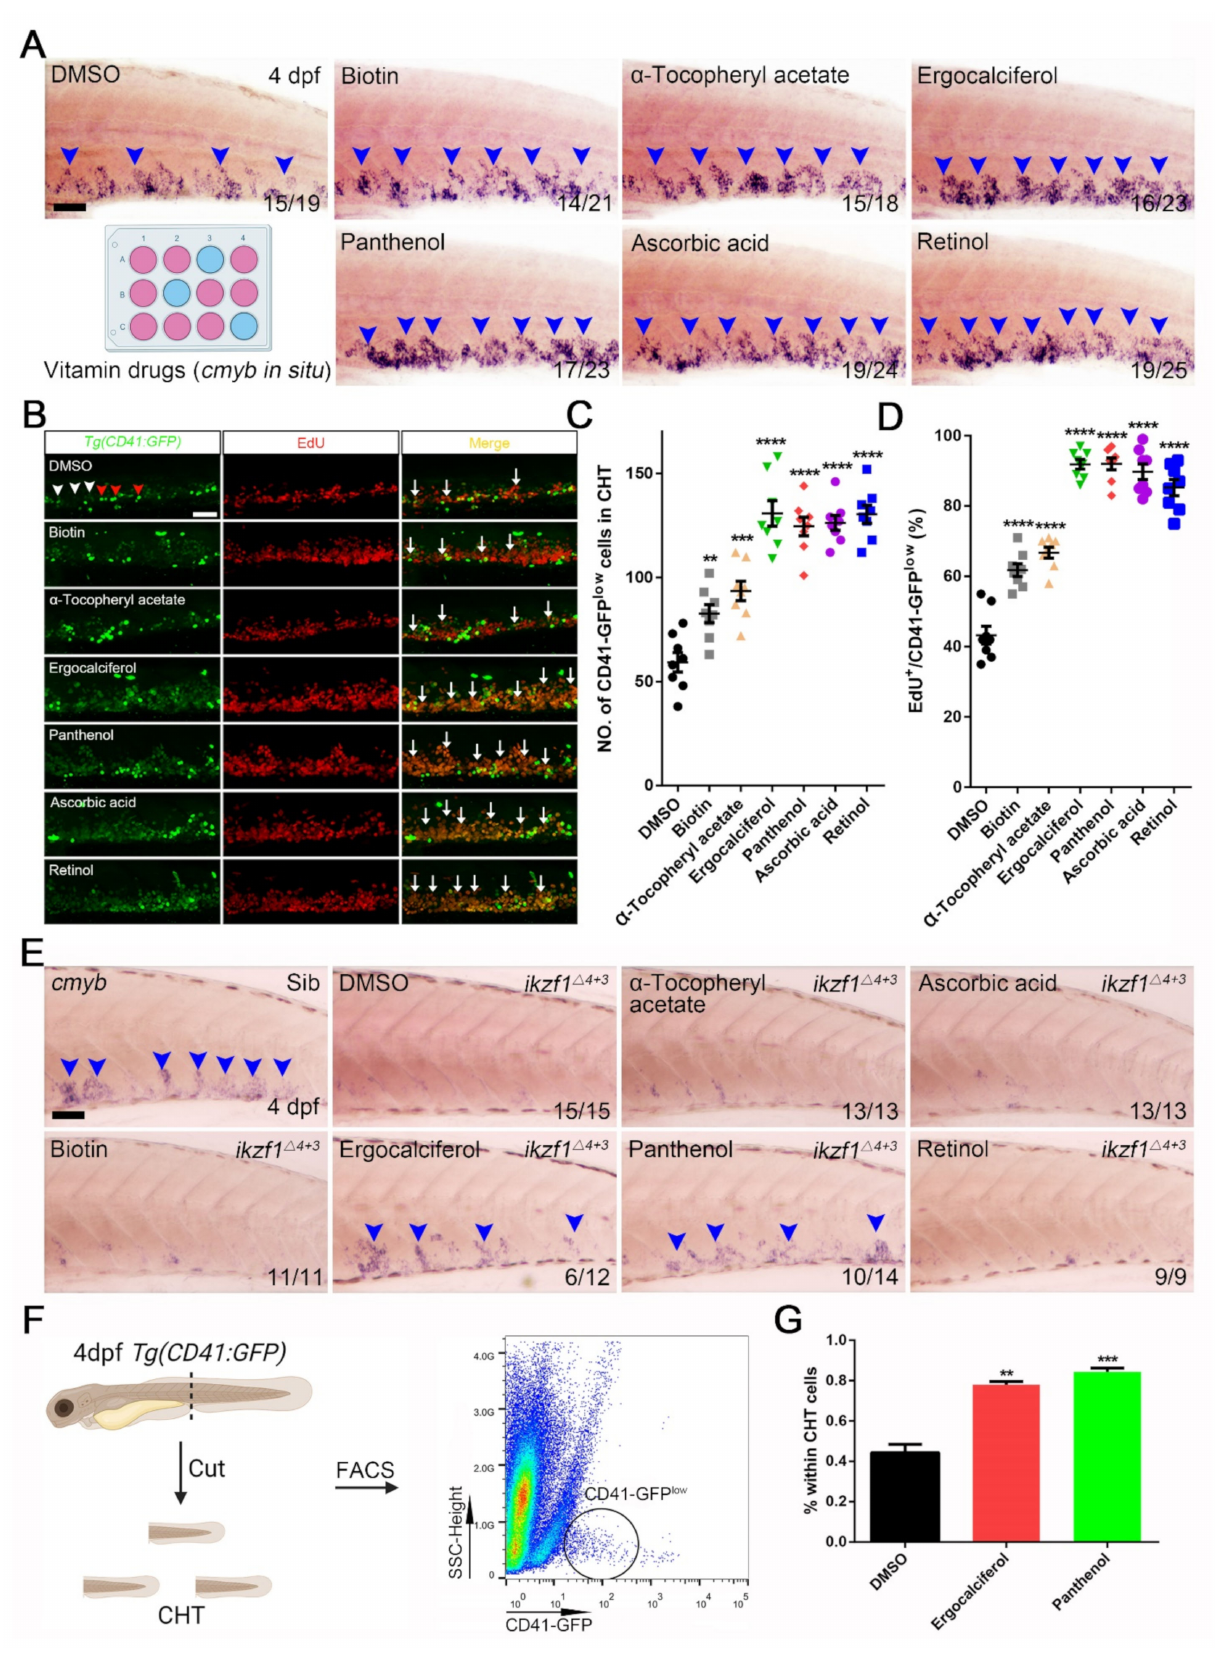
Figure 3. Vitamin drugs boost HSPCs expansion in zebrafish embryos and mitigate HSPCs expansion defective phenotype in ikzf1 − / − mutants. ( A ) Whole mount in situ hybridization (WISH) of cmyb after treating with vitamin drugs,